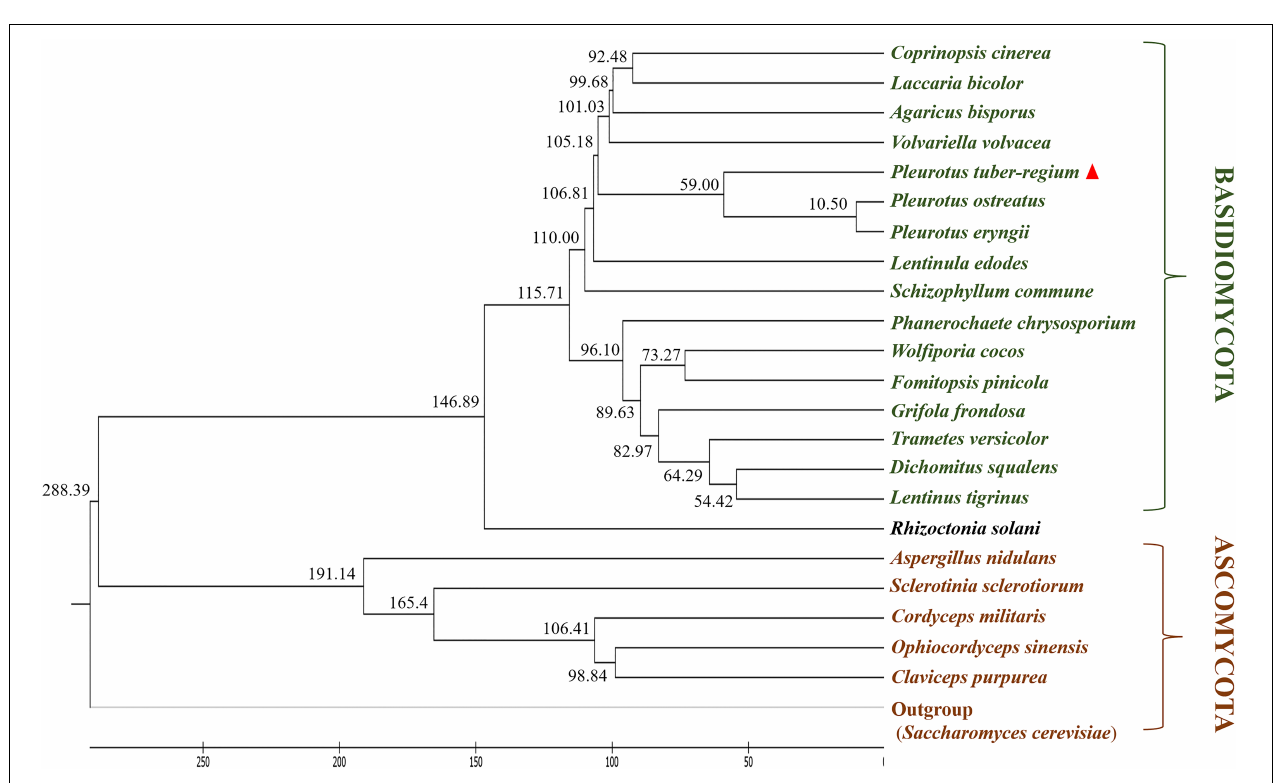
FIGURE 6 | Phylogenetic tree of P. tuber-regium demonstrating the evolutionary distance with other fungal species. Time scale along the bottom indicates millions of years ago. The inferred divergence time of fungal species is located on the left side of each node.